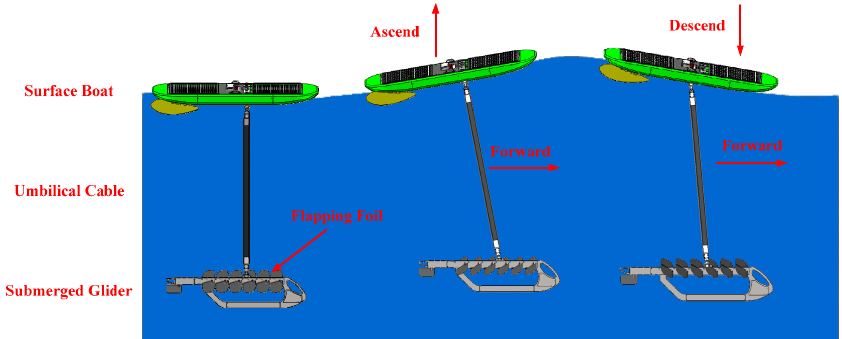
Figure 1. The wave glider and operation principle for the wave propeller.